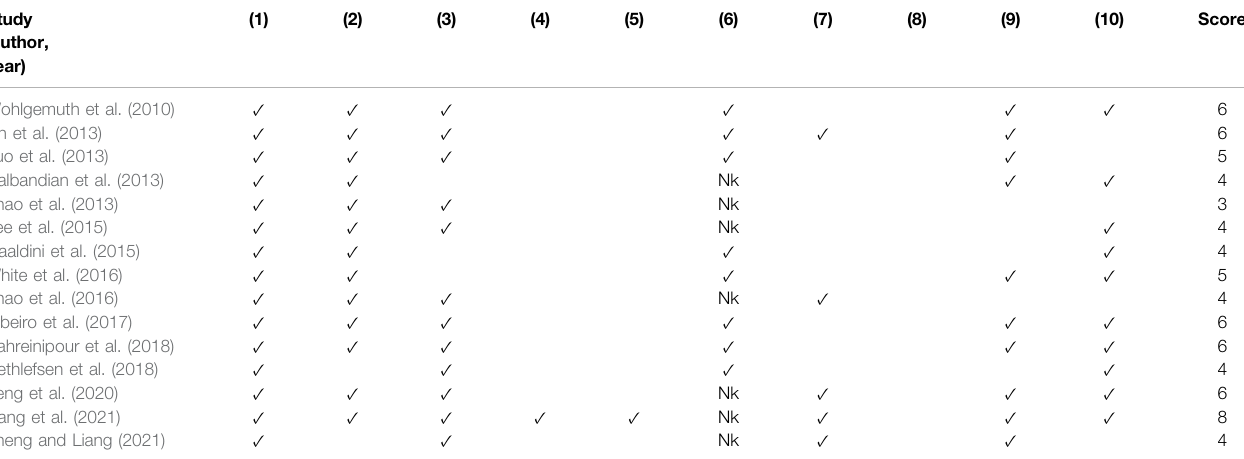
TABLE 3 | Quality assessment of the included